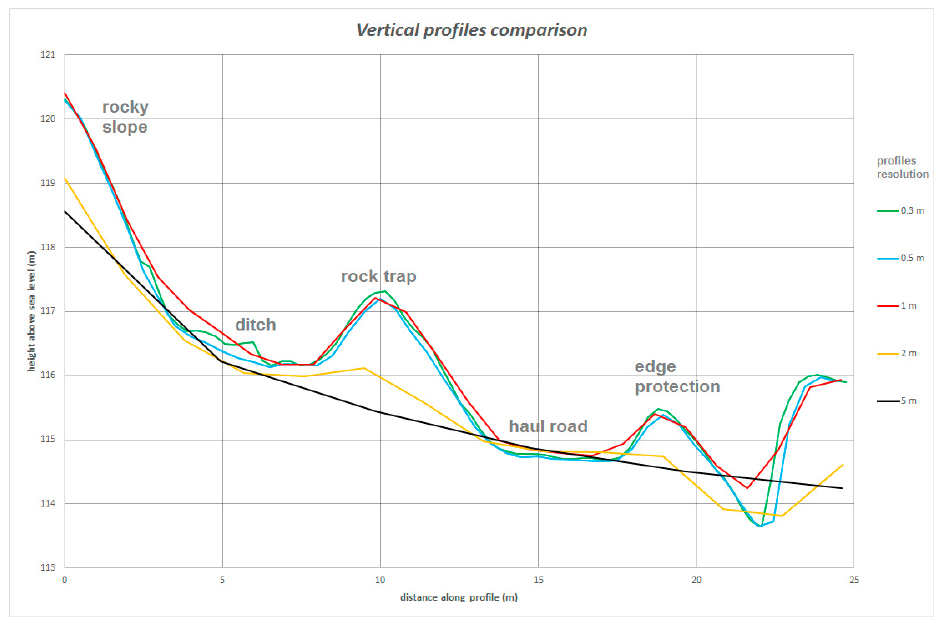
Figure 14. Comparison of vertical profiles, extracted from the DEM at different resolutions. The vertical axis is exaggerated by a factor of two.